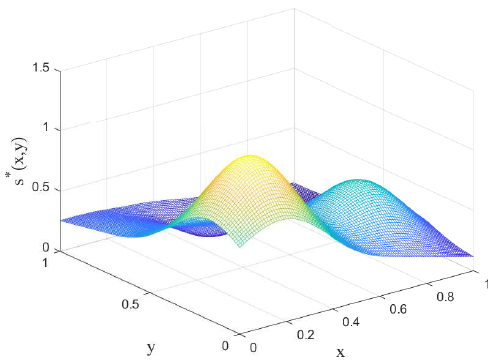
Figure 13. The approximation function s ∗ ( x , y ) on [ 0,1 ] × [ 0,1 ] .